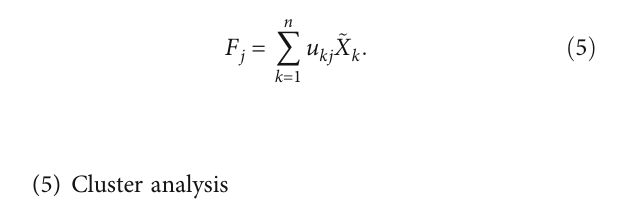
Figure 3: Comparison of salient features of each cluster